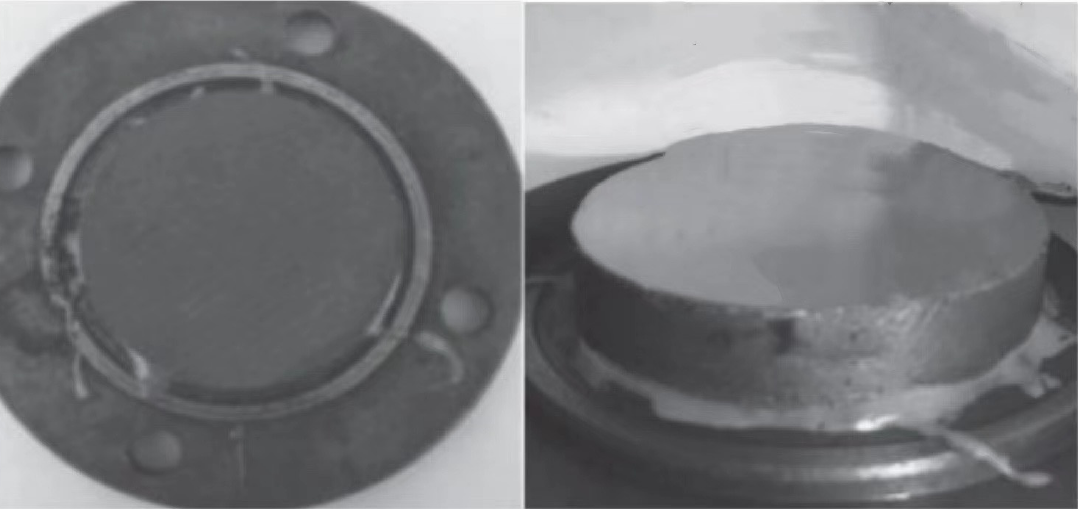
Figure 8. Surface renderings of the aluminum-based diamond before and after Electrolytic in-process dressing technology (ELID) processing